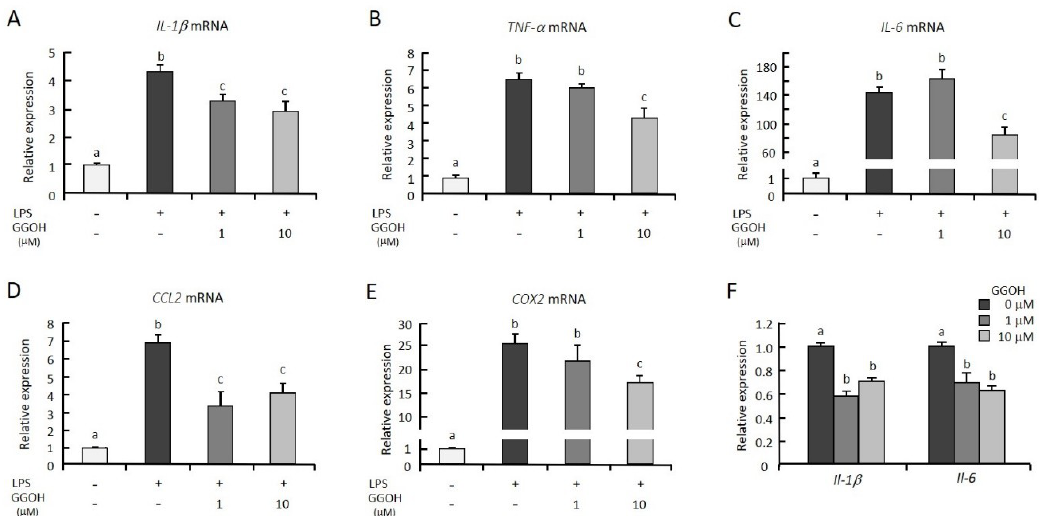
Figure 1. Geranylgeraniol (GGOH) suppressed the mRNA levels of inflammatory genes in lipopolysaccharide (LPS)-stimulated THP-1 and RAW264.7 cells. ( A – E ) THP-1 cells were di ff erentiated with phorbol 12-myristate 13-acetate (PMA), then preincubated with or without GGOH for 24 h. After a 3 h LPS stimulation, the cells were harvested, and the RNA was isolated, as described in the experimental procedures. ( F ) Murine RAW264.7 cells were preincubated with GGOH for 24 h. After a 3 h stimulation with LPS, the cells were harvested, and the RNA was isolated. The mRNA levels of the inflammatory genes were then measured by quantitative RT-PCR. All values represent the mean ± SEM; n = 3. The values with di ff erent letters (a, b, and c) are significantly di ff erent at p < 0.05, as assessed by one-way analysis of variance, followed by Fisher’s least significant di ff erence test.